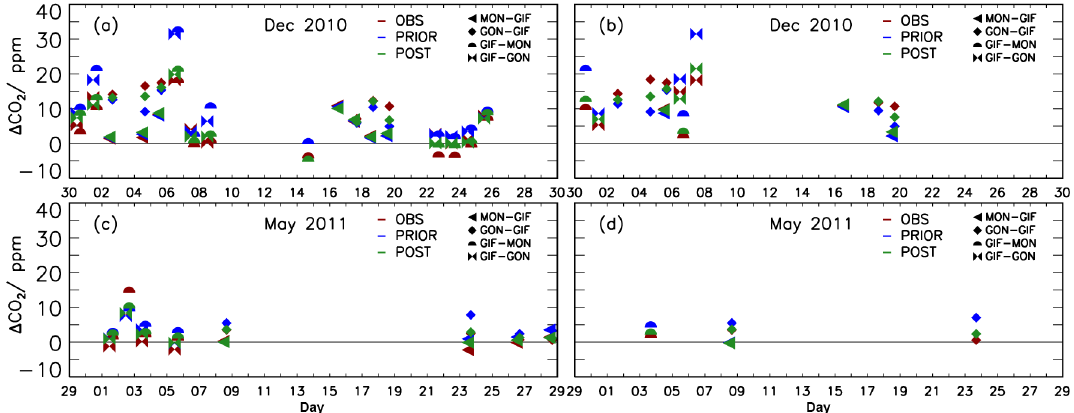
Figure 4. Time series of mean afternoon (12:00–16:00) CO 2 mole fraction differences ( (cid:49) CO 2 ) between downwind and upwind sites for December 2010 (upper panels) and May 2011 (lower panels). Measured CO 2 mole fraction differences (red); prior (blue) and posterior (green) CO 2 mole fraction differences. (a, c) Selection of gradients relies on wind direction ranges of the initial inversion configuration. (b, d) Wind direction ranges are limited to a narrow SW–NE wind corridor across the city following the reference inversion configuration (see Sect.